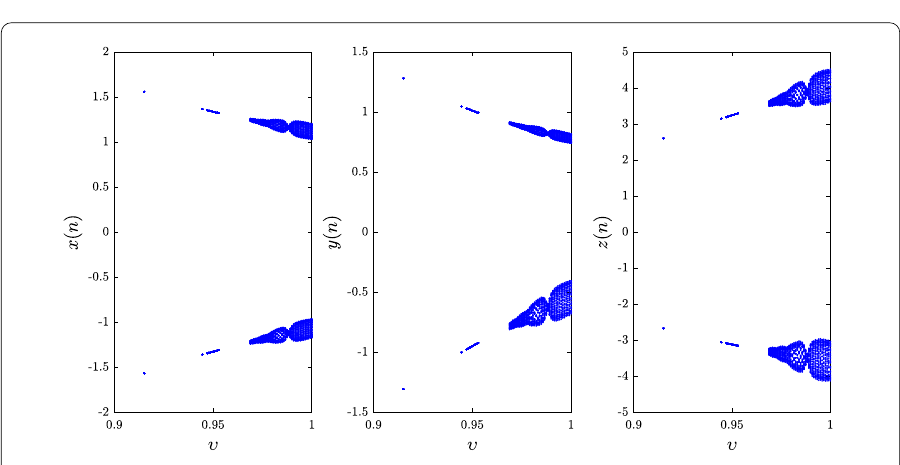
Figure 19 Bifurcation diagram of the fractional Rössler map with υ ∈ [0,1] as the critical parameter, ( a 1 , a 2 , a 4 , a 5 , a 6 , a 7 ) = (–1.9,0.2,–2.3,2,–0.6,–1.9) and ( x (0), y (0), z (0)) =